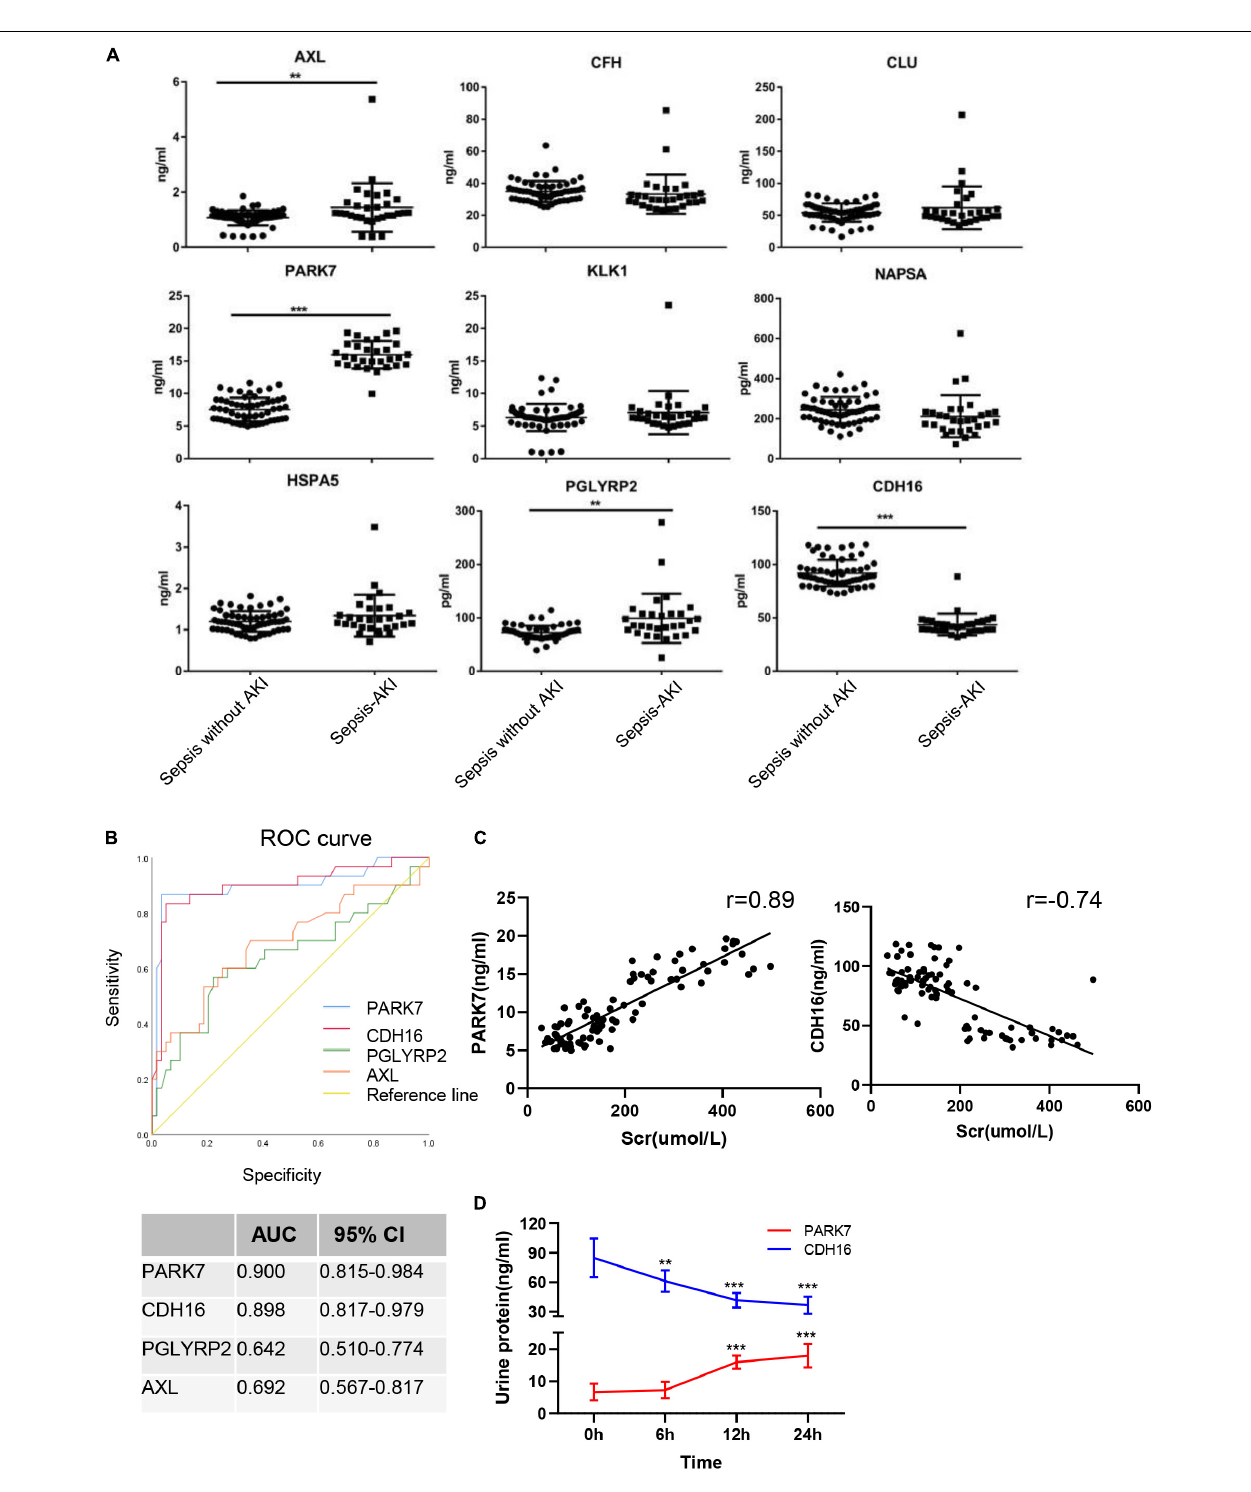
FIGURE 8 | Verification of sepsis-induced AKI-specific biomarkers in sepsis human patients. (A) The concentration of nine proteins was validated by ELISA in urine from sepsis-induced AKI patients and non-sepsis-induced AKI patients. ∗ P < 0.05; two-tailed unpaired Student’s t -test. (B) Validation of 4 differentially expressed proteins by testing their performance in differentiating injury specificity by AUC for PARK7, PGLYRP2, AXL, and CDH16. (C) Pearson correlation analysis was performed between expression of PARK7 and CDH16 and Scr. Both PARK7 and CDH16 were correlated to Scr. P < 0.01; (D) The protein expression of PARK7 and CDH16 in urine from ten patients were detected by Elisa kit at 0, 6, 12, and 24 h after diagnosis with sepsis. ** P < 0.01; *** P < 0.001;Compared with 0 h.